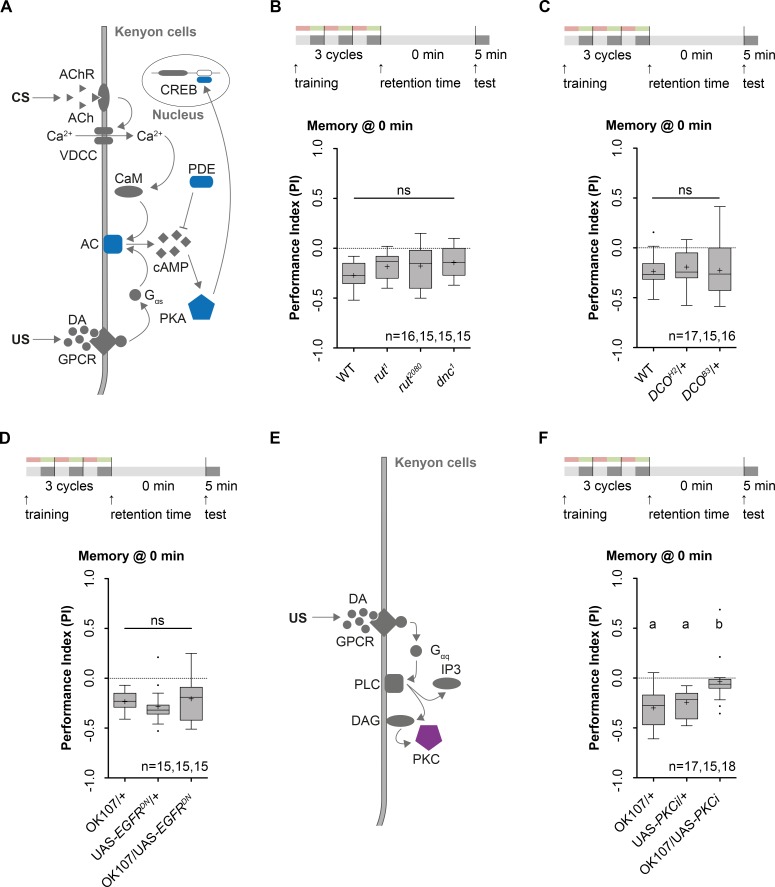
Odor-high salt learning and/or memory following three cycle standard training is independent of the cAMP/PKA pathwayTraining protocols are shown at the top of each panel. A: Working hypothesis that links the classical cAMP/PKA signaling pathway to the association of the unconditioned (US, high salt) and conditioned stimulus (CS, odor). Joined presentation of US and CS activates AC through simultaneous activation of Ca2+/CaM and G-protein stimulation. This results in the activation of the cAMP/PKA pathway. The activation of PKA leads either to the phosphorylation of a variety of downstream targets to change neuronal signaling on a shorter time scale or to phosphorylate CREB to form long-lasting memory. An arrowhead indicates stimulatory effects, whereas inhibitory effects are represented as a bar. GPCR: G-protein coupled receptor, VDCC: voltage-dependent calcium channel, ACh: acetylcholine, DA: dopamine, AC: adenylate cyclase, CaM: calcium/calmodulin-dependent protein kinase, cAMP: cyclic AMP, PDE: phosphodiesterase, PKA: protein kinase A, CREB: cyclic AMP response element-binding protein. B:
rut1, rut2080 and dnc1 mutant larvae showed lARM comparable to wild type controls (One way ANOVA, p = 0.14). C:
DCO encodes for the major catalytic subunit of PKA in Drosophila. Adults covering heterozygously the alleles DCOB3/+ and DCOH2/+ show a 50% reduction of PKA activity. DCOB3/+ and DCOH2/+ heterozygous mutant larvae showed normal lARM (One sample t test, p = 0.001 and p = 0.004), they performed at the same level as wild type larvae that served as a genetic control (One way ANOVA, p = 0.84). D: Epidermal growth factor receptor (EGFR) signaling to a Ras/Neurofibromatosis type I (NFI) pathway was reported to activate PKA. Expression of a dominant-negative isoform of EGFR (EGFRDN) in the MB KCs via OK107-Gal4 does not affect lARM (One sample t test, p = 0.0017), as the experimental group performed at the same level as both genetic controls (Kruskal-Wallis, p = 0.14). E: Working hypothesis for an alternative signaling pathway that allows larvae to form lARM. GPCR activation activates PLC that binds to downstream target elements, which stimulate PKC. Activation of typical forms of PKC needs also the binding of intracellular Ca2+. An arrowhead indicates stimulatory effects, whereas inhibitory effects are represented as a bar. GPCR: G-protein coupled receptor, DA: dopamine, PLC: phospholipase C, PKC: protein kinase C, DAG: diacylglycerol, IP3: inositoltriphosphat. F: Suppression of PKC activity in MB KCs by expressing an inhibitory pseudosubstrate of PKC (PKCi) under the control of OK107-Gal4 leads to a decrease in odor-high salt learning and/or memory (Kruskal-Wallis, p = 0.0001). Differences between groups are depicted above the respective box plots, at which ns indicates p≥0.05. Different lowercase letters indicate statistical significant differences at level p<0.05. Grey boxes show memory performance above chance level (p<0.05), whereas white boxes indicate random distribution (p≥0.05). Small circles indicate outliers. Sample size is n = 16 for each group if not indicated otherwise.